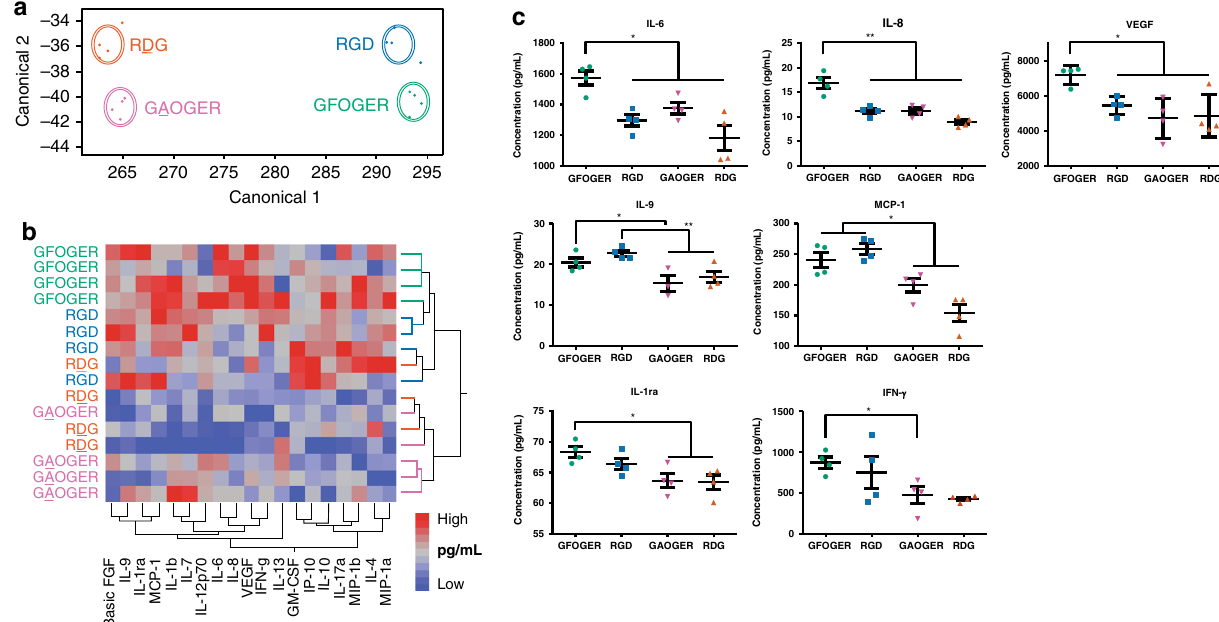
Fig. 6 Integrin-speci fi c peptide-functionalized hydrogels modulate in vitro cytokine secretome of encapsulated hMSC. Conditioned media from encapsulated hMSC in peptide-functionalized hydrogels was analyzed using bead-based multiplex technology for multiple cytokines. a Linear discriminant analysis of secreted cytokines from encapsulated hMSC. Each point represents a sample and each multivariate mean is a labeled circle corresponding to a 95% con fi dence limit for the mean. Groups that are signi fi cantly different have non-intersecting circles. b Hierarchical clustering using Ward ’ s method shows clustering of cytokine pro fi les from adhesive (GFOGER, RGD) hydrogels and non-adhesive (GAOGER, RDG) hydrogels. c Cytokines exhibiting signi fi cantly different secretion levels from hydrogel-encapsulated hMSC. n = 4 biologically independent samples, mean ± SE; * p < 0.05, ** p < 0.01. One- way ANOVA was used to detect statistical differences followed by Tukey ’ s multiple comparisons test with adjustment for multiple